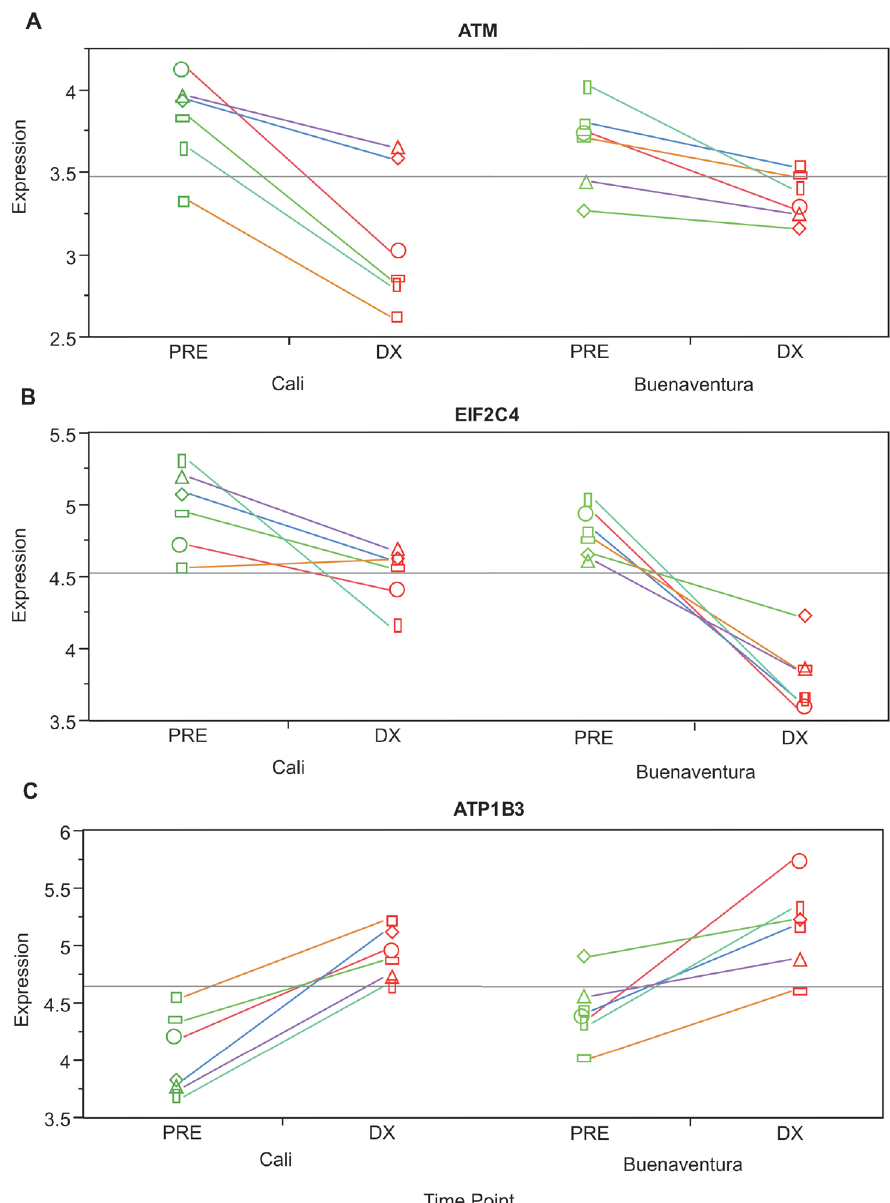
Fig 6. Transcriptional interaction effect between location and timepoint. Examples of the interaction effect showing gene ATM up-regulation in Cali (A), gene EIF2C4 down-regulation in Cali (B) and gene ATP1B3 with no significant change